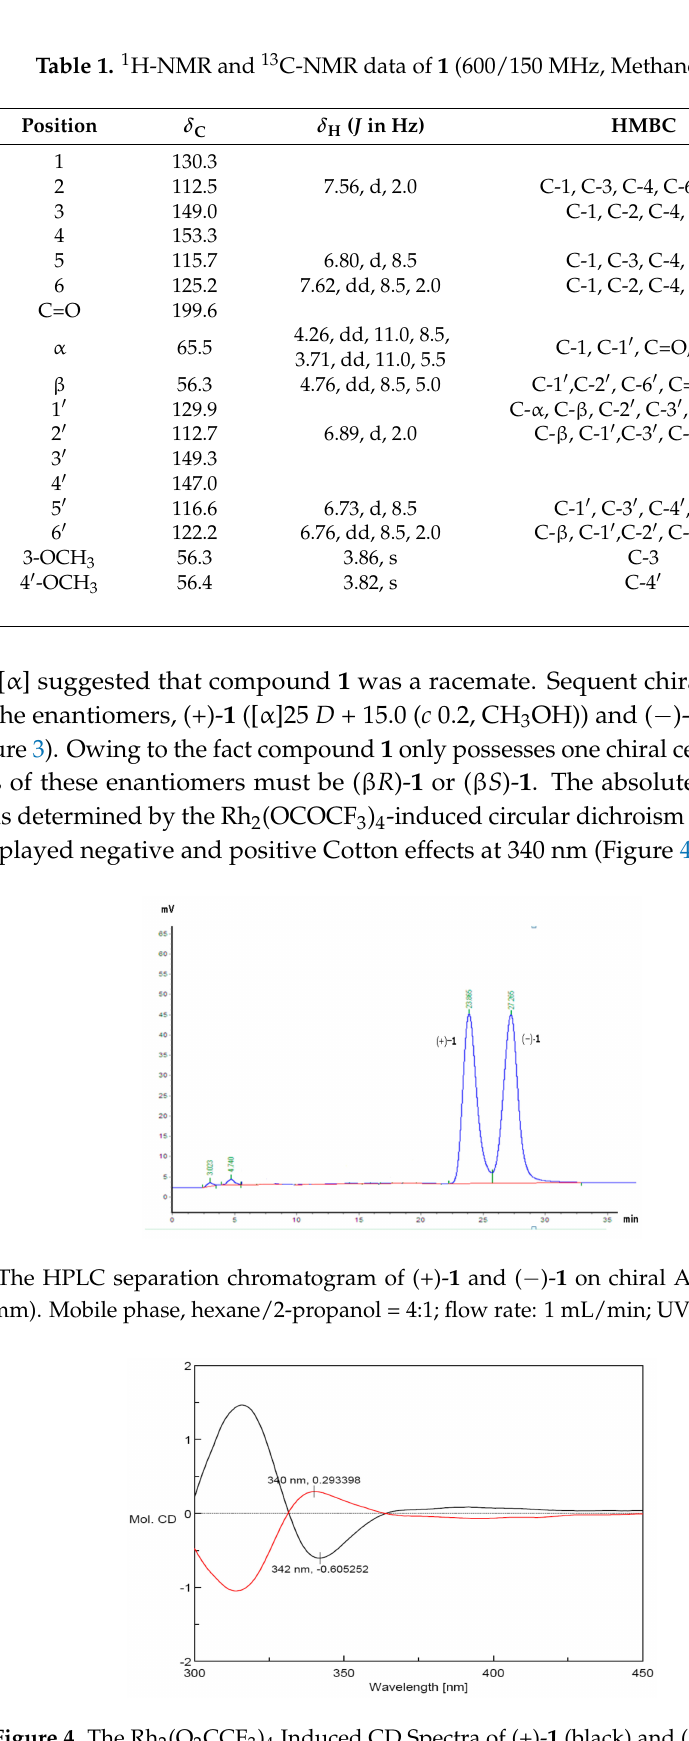
Figure 4. The Rh 2 (O 2 CCF 3 ) 4 Induced CD Spectra of (+)- 1 (black) and ( − )- 1